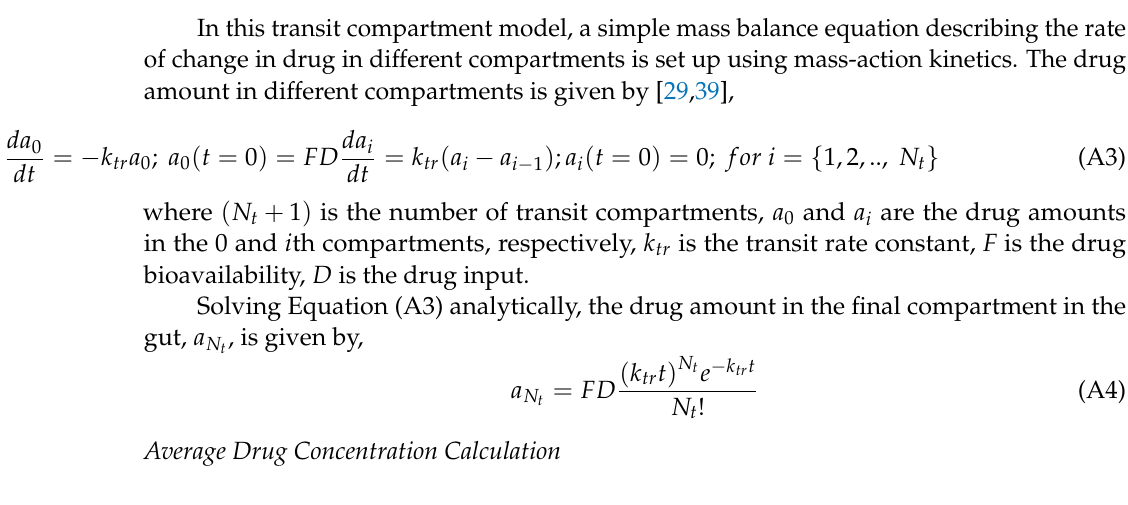
Figure A1. Schematic of hydroxyurea pharmacokinetic model.